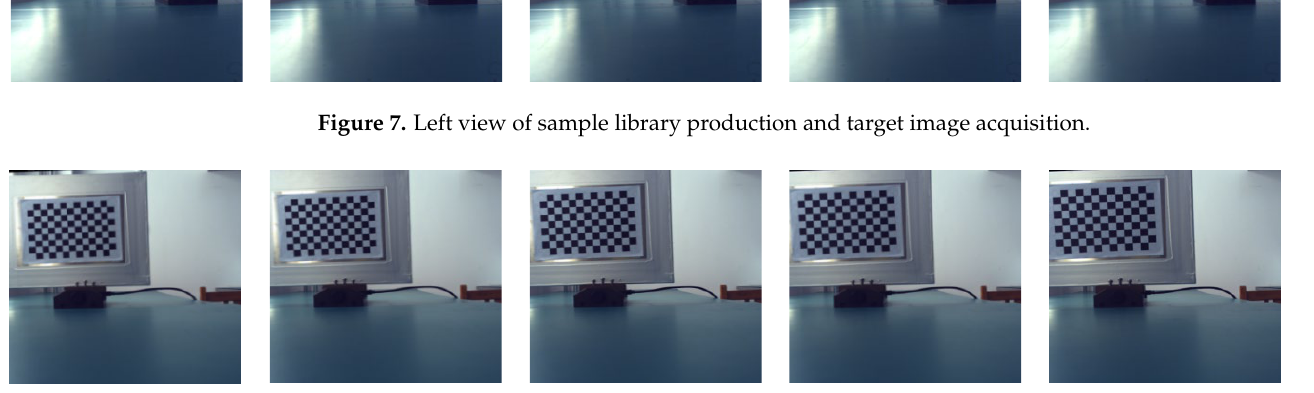
Figure 8. Right view of sample library production and target image acquisition.